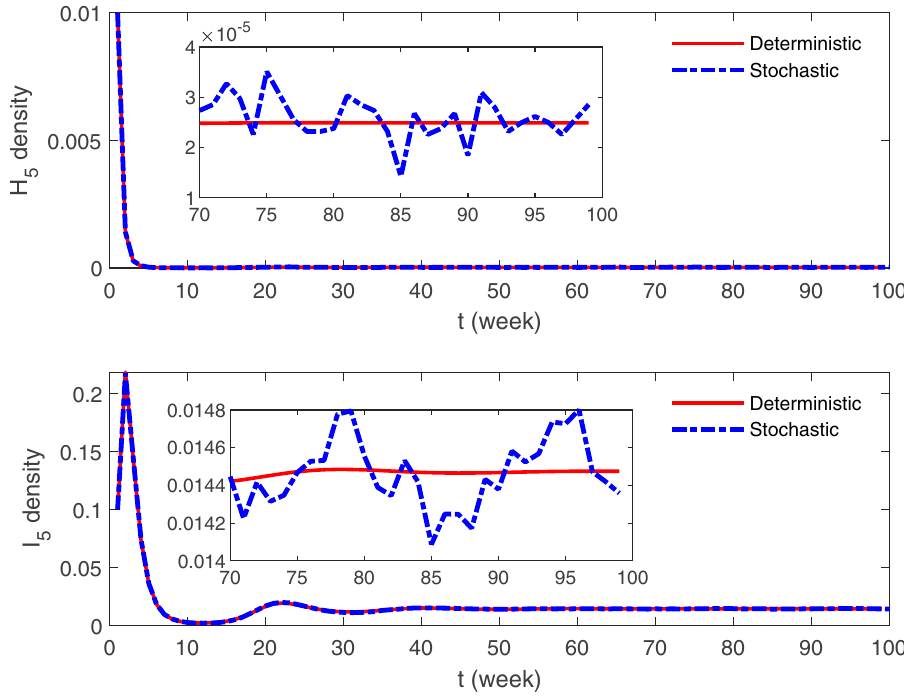
Figure 3. A realization of a stochastic SHIRS model with the degree of 5 and its deterministic counterpart. The values of parameters used in this simulation are listed in Table 2. The stochastic simulation is implemented by the event algorithm of Gillespie with transition rates listed in Table 1. The deterministic curve is generated according to the Eq.